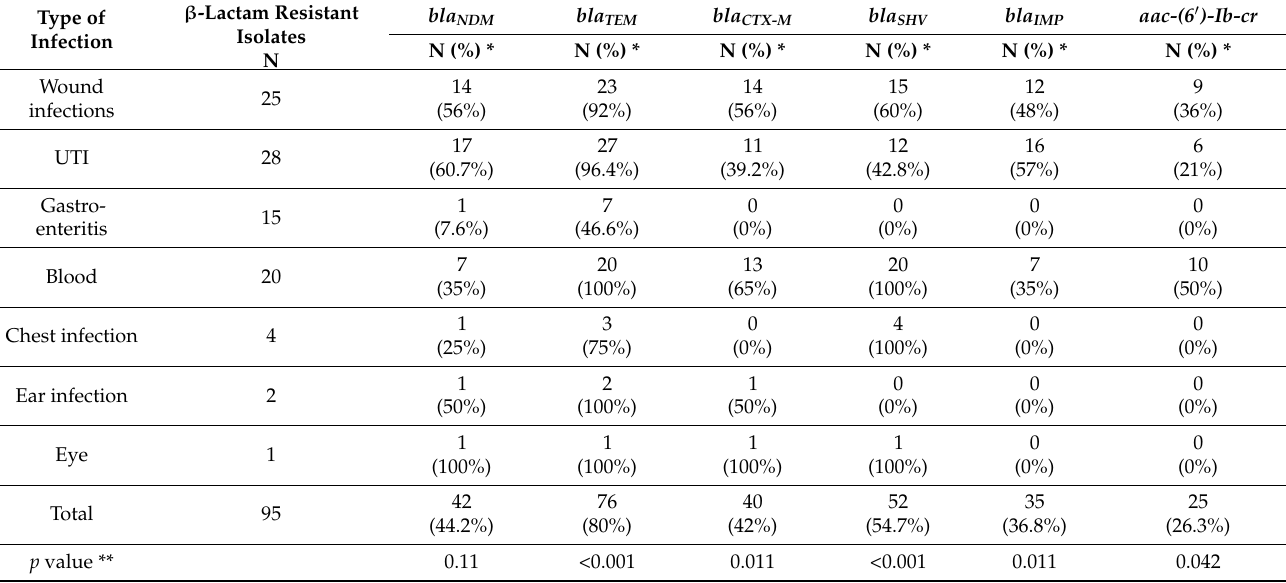
Table 4. Distribution of detected MBLs and ESBLs